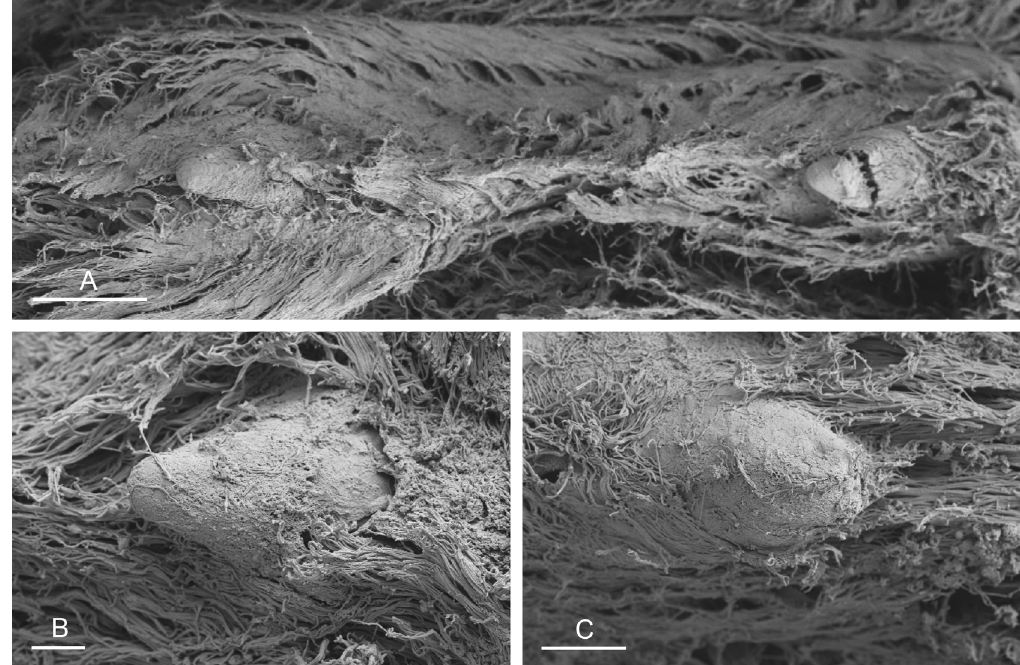
Fig. 22. Paromoionchis tumidus (Semper, 1880) comb. nov. unit #2, penial hooks. A . Indonesia, Sumatra [1794] (UMIZ 00138). B . Philippines, Luzon [3237] (PNM 041265). C . Same as B. Scales: A = 20 μm; B = 4 μm; C = 6